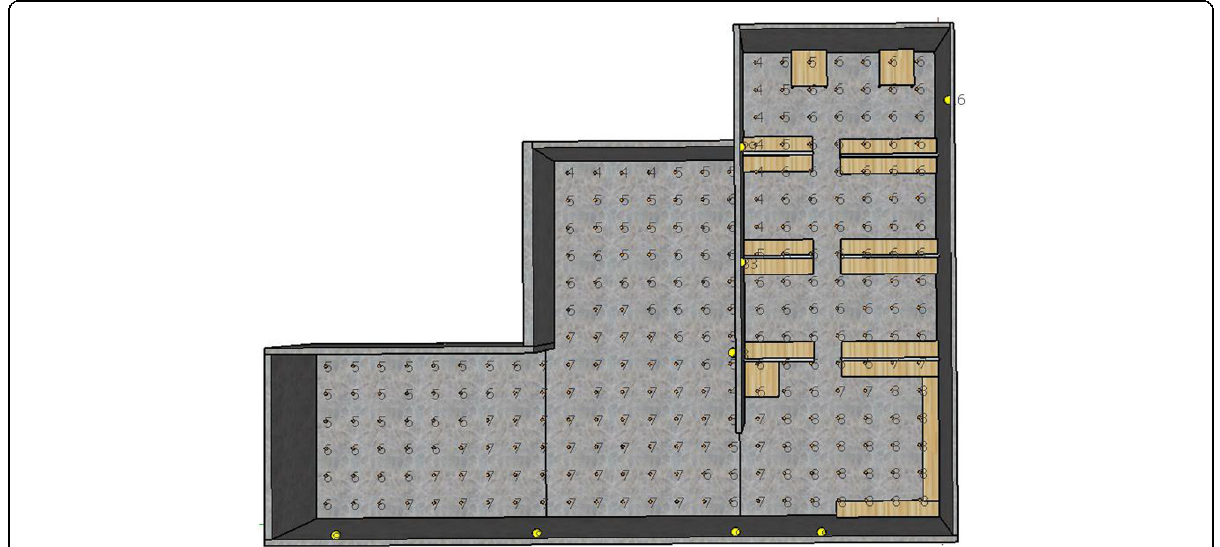
Fig. 2 The first diameter coverage. In the above positioning scenario, there are 8 optimal deployment positions number of network elements, namely, 16, 29, 33, 43, 81, 88, 95, 98. The number of the first diameter that the user terminal received is represented by the digit of corresponding location